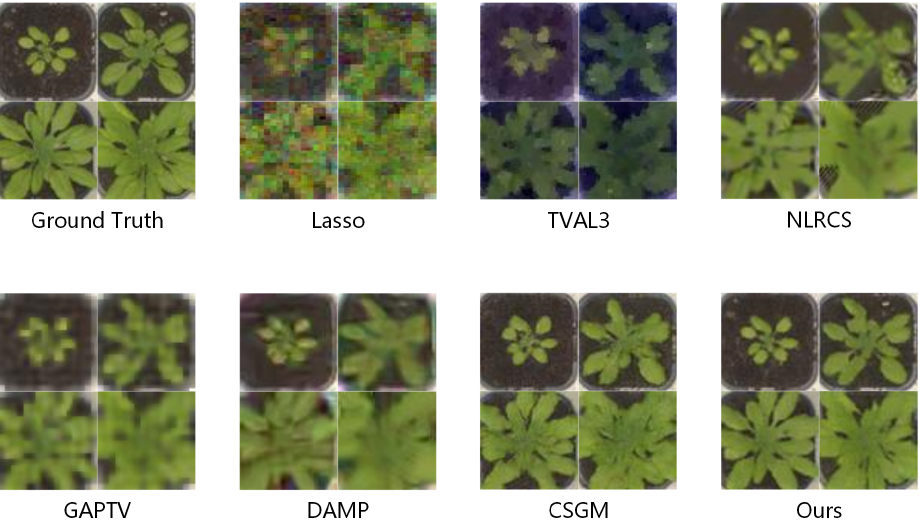
Figure 3. Four examples of plant seedling images reconstructed by various methods. The compres- sion rate is set to cr = 20.